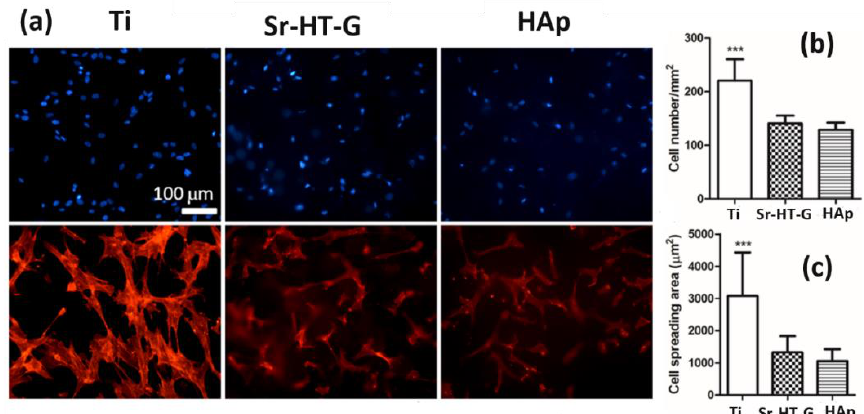
Figure 12. Biocompatibility tests of different substrates using bone marrow stem cells. ( a ) BMSC morphology on Ti, Sr–HT–G, and HAp surfaces. Cell nucleus (blue) and F-actin (red) were stained. ( b ) Cell density and ( c ) spreading area on various substrates. ** p < 0.01 and *** p < 0.001 compared to Sr–HT–G and HAp surfaces.